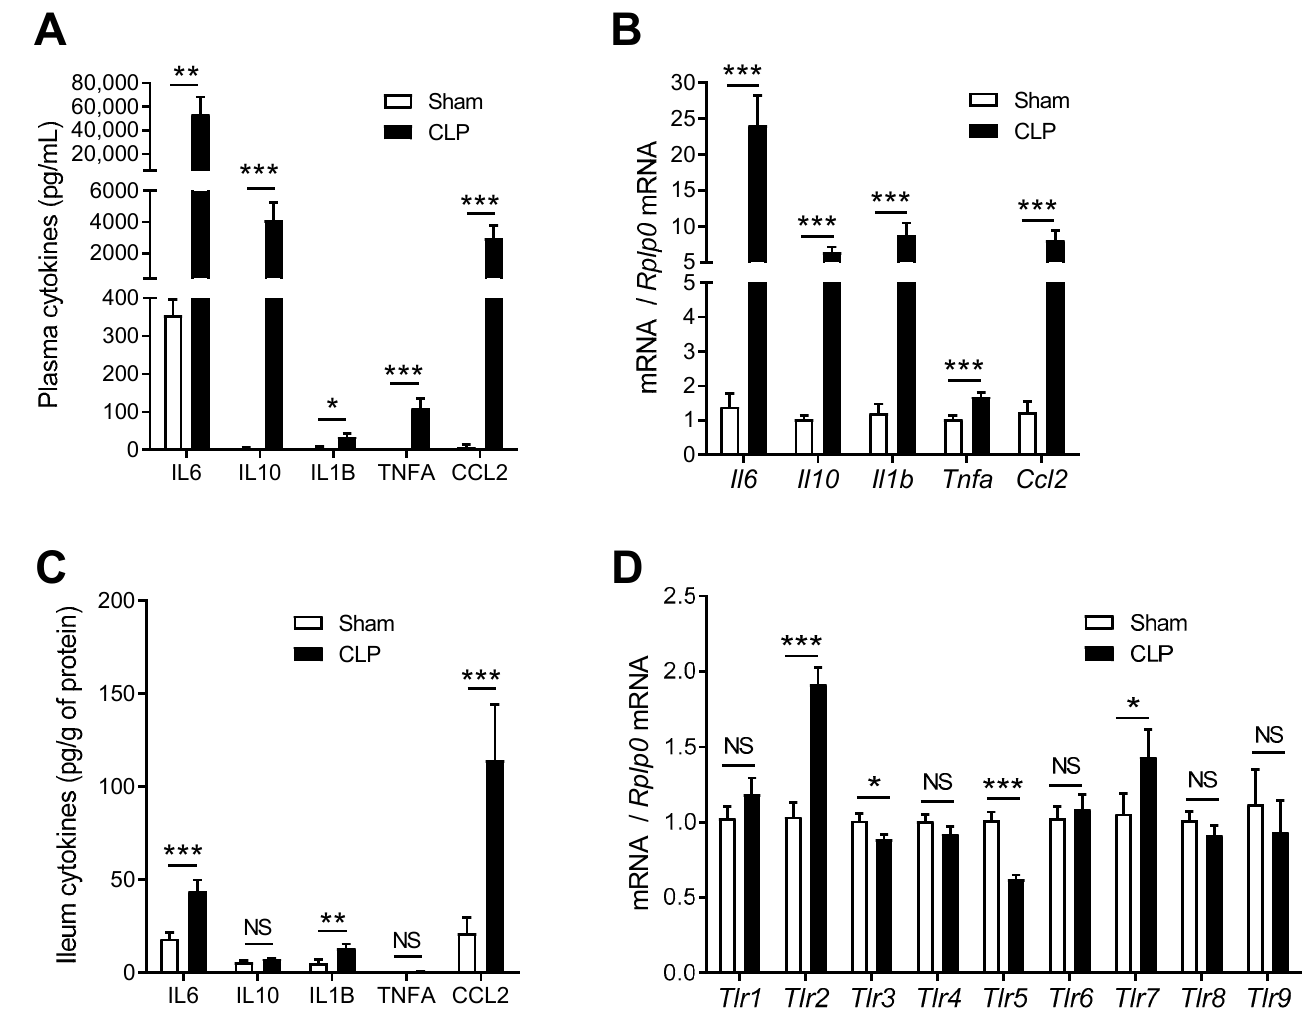
Figure 1. Cecal ligation puncture (CLP) induces systemic inflammation and modulates inflammatory gene expression in the gut. Evaluation of the inflammatory status of mice 3 h after the onset of CLP or in sham control mice ( n = 10). ( A ) Levels of plasma cytokines (pg/mL): interleukin-6 (IL6), interleukin-10 (IL10), interleukin-1 beta (IL1B), tumor necrosis factor alpha (TNFA) and C-C motif chemokine ligand 2 (CCL2). ( B ) Quantification of cytokine mRNA levels (compared to ribosomal protein lateral stalk subunit P0 ( Rplp0 ) mRNA) in the ileum. ( C ). Levels of ileum cytokines (pg/g of protein). ( D ) . Quanti fi cation of toll-like receptor (TLR) mRNA levels (compare to Rplp0 mRNA) in the ileum. Statistical analyses were performed using the matched Student’s t -test or Mann–Whitney test. NS, not signi fi cant; * p < 0.05, ** p < 0.01 and *** p < 0.001. All results are expressed as mean ± SEM.